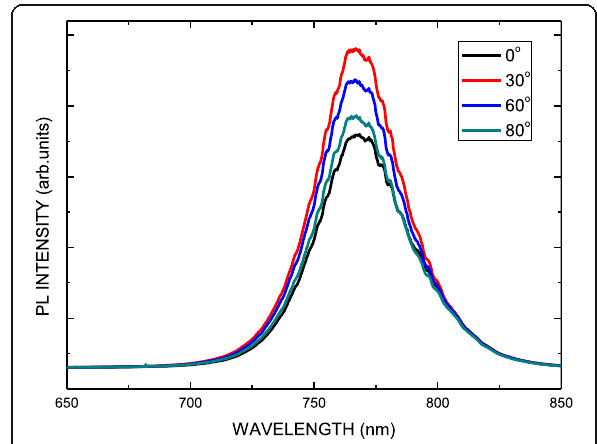
Fig. 6 PL spectra of MAPbI 3 perovskite films on PEDOT:PSS/oblique ITO layer/glass for various oblique